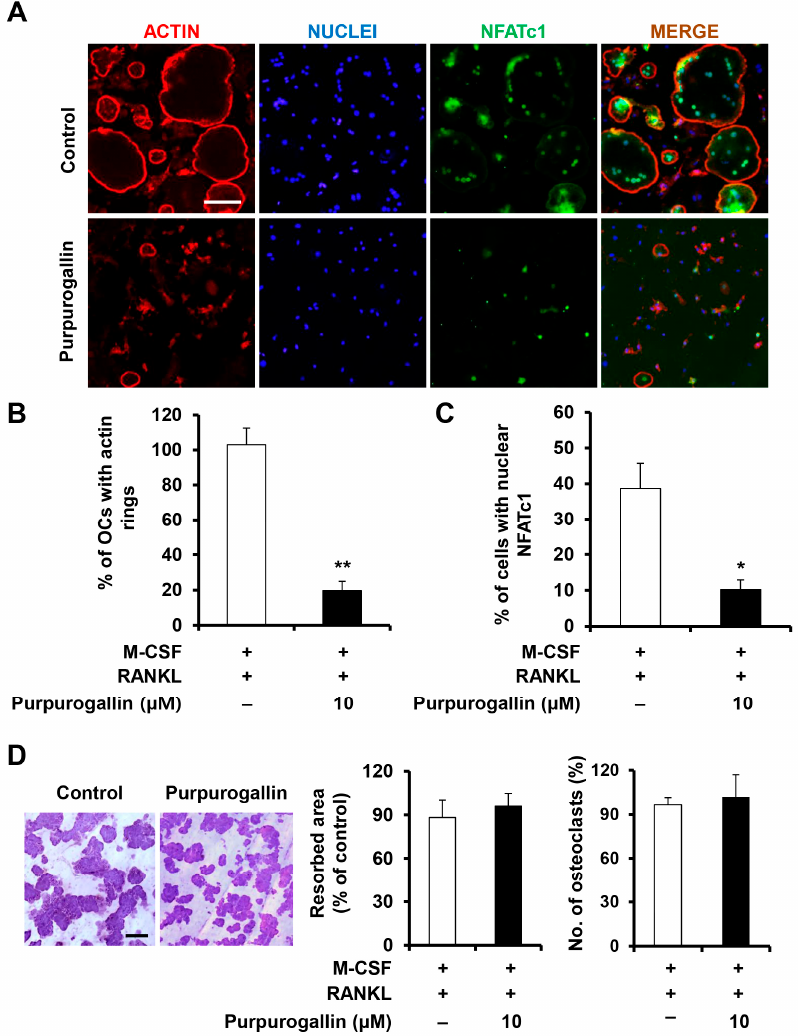
Figure 3. Purpurogallin inhibits the formation of actin rings, but does not suppress the formation of resorption pits. ( A ) BMMs seeded onto glass coverslips were cultured in an osteoclastogenic medium containing M-CSF (10 ng/mL) and RANKL (20 ng/mL) with or without purpurogallin (10 µ M). The cells were stained with the anti-NFATc1 antibody, and actin rings and nuclei were stained with rhodamine-conjugated phalloidin and DAPI, respectively. Scale bar, 100 µ m; ( B ) The number of actin rings and ( C ) the number of cells with nuclear NFATc1 were analyzed. * p < 0.05, ** p < 0.01. ( D ) BMMs were plated onto bone slices and incubated with M-CSF (10 ng/mL) and RANKL (20 ng/mL) for 3 days to induce osteoclast differentiation. Next, the cells were treated with or without purpurogallin (10 µ M) for 2 days. Multinucleated osteoclasts were counted, and resorption pits were visualized by hematoxylin staining.